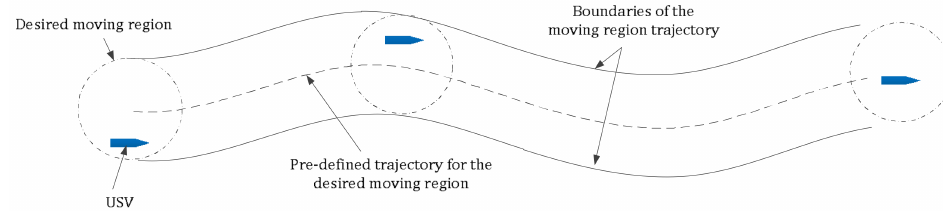
Figure 1. Concept of non-strict trajectory